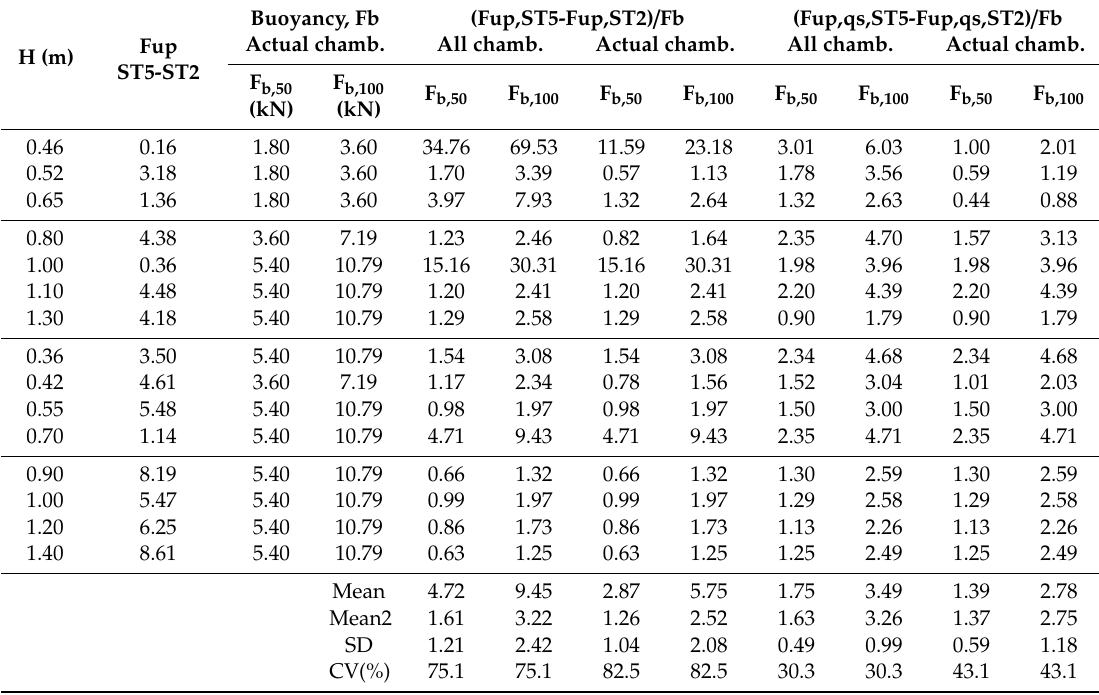
Table 6. Comparison of the calculated buoyancy forces with the measured uplift forces on the deck with cross-frames (ST2) and the one with diaphragms